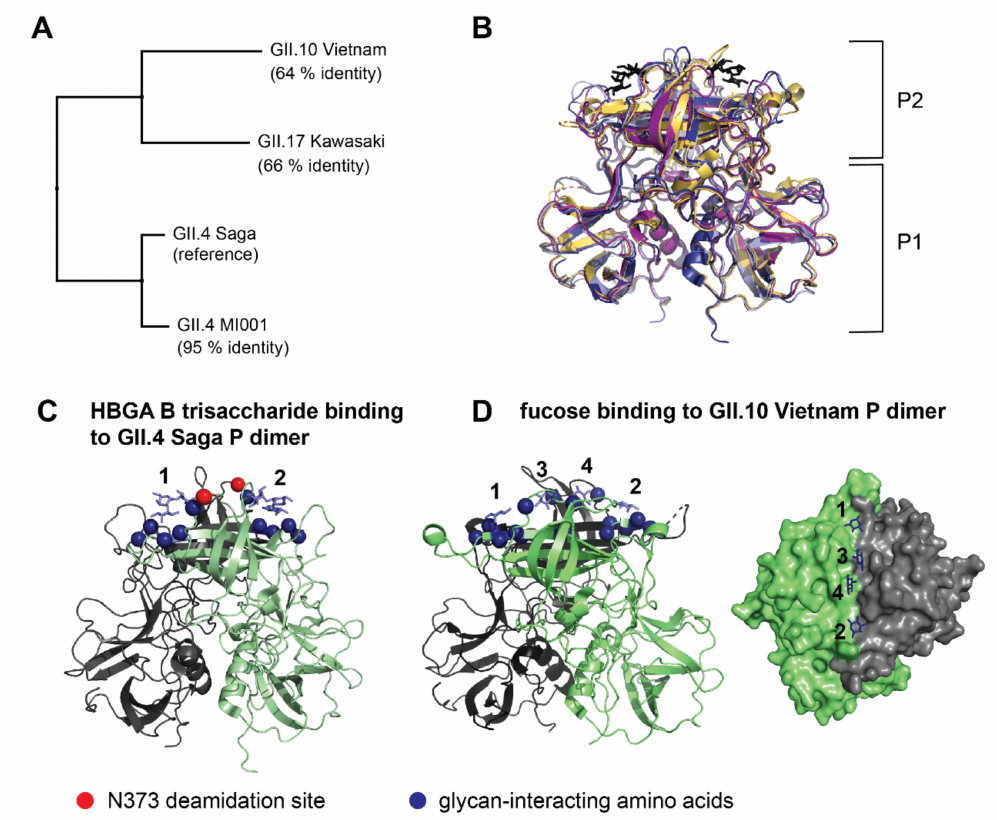
Figure 1. Comparison of human norovirus VP1 sequences ( A ) and P dimer structures with HBGA B trisaccharide (black) binding to the canonical binding site ( B ). P dimer sequences of three virus strains were aligned to the already investigated [15] GII.4 Saga strain as reference. For the GII.4 MI001 P dimer, a homology model was created for comparison using the GII.4 Farmington Hills P dimer structure with 94% sequence identity to MI001 as reference. Crystal structures of GII.4 Saga (pdb 4X06, dark blue), GII.10 Vietnam (pdb 3ONY, yellow), GII.17 Kawasaki (pdb 5F4O, purple) and the homology modelled structure of GII.4 MI001 (light blue) were superimposed in PyMOL with the following RMSDs to GII.4 Saga: 7.4 Å (GII.10 Vietnam), 6.5 Å (GII.17 Kawasaki), 1.6 Å (GII.4 MI001). P1 and P2 indicate the respective domains of the P dimer. ( C ) HBGA B trisaccharide binding to the two canonical binding sites of the GII.4 Saga P dimer (pdb 4x06). Amino acids contributing to the binding site (blue spheres) and the GII.4 N373 deamidation site (red sphere) are indicated in both monomers of the P dimer (green, grey). ( D ) Fucose binding to the GII.10 Vietnam P dimer (canonical binding sites: 1,2; additional binding sites: 3,4). The surface representation shows the glycan binding cleft in top-view (pdb